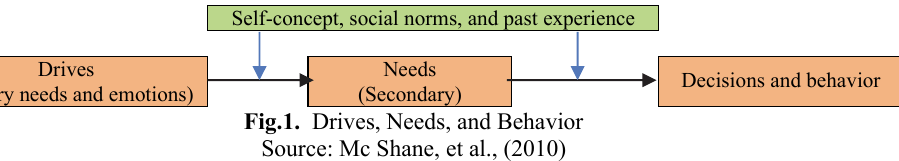
Fig.1. Drives, Needs, and Behavior Source: Mc Shane, et al.,